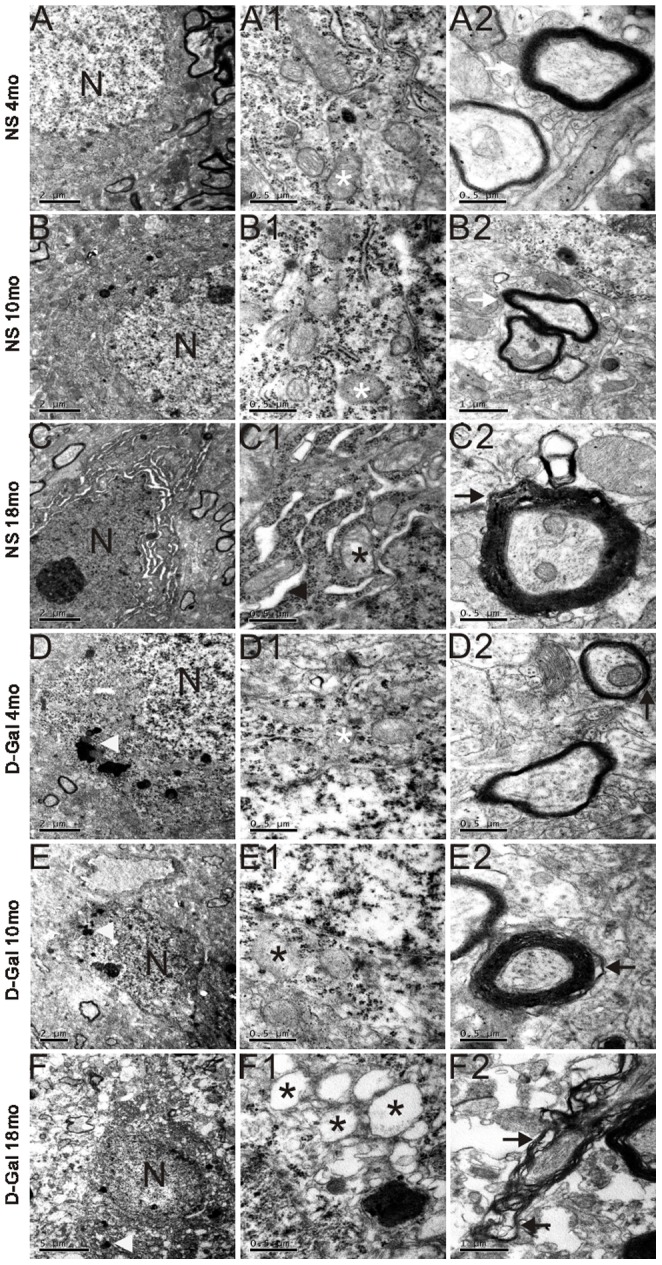
Age-related changes in the ultrastructural morphology in the auditory cortex.Ultrastructural changes in the auditory cortex at different ages in the NS and D-Gal groups. Normal nucleus, uniformly chromatin, and normal mitochondria (white asterisks) are shown in the 4- and 10-month-old NS group and the 4-month-old D-Gal group, irregular nucleus, condensed chromatin, and swollen and vacuolated mitochondria (black asterisks) were found in the 18-month-old NS group, 10- and 18-month-old D-Gal group. Intact and compact myelin (white arrows) was in the 4- and 10-month-old NS group, swollen and disrupted myelin (black arrows) was in the 18-month-old NS group and different D-Gal groups. Enlarged endoplasmic reticulum was found in the 18-month-old NS group. Accumulated lipofuscin (white arrowheads) were shown in the D-Gal groups.